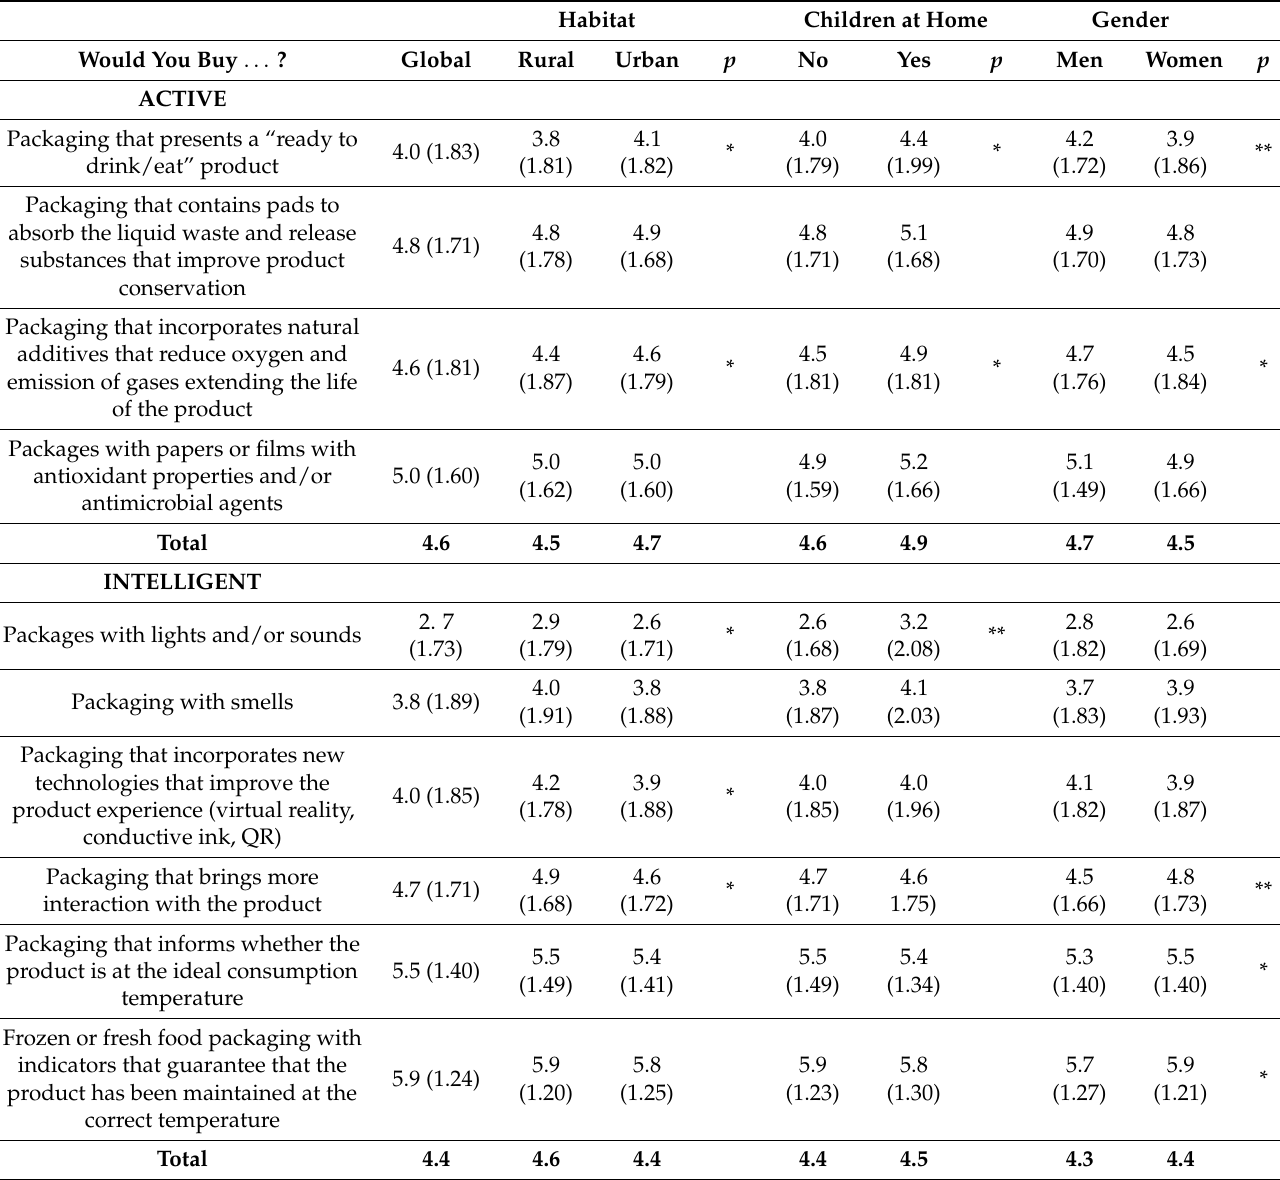
Table 3. Mean values (and standard deviations) of the respondents’ views on purchase intention of AIP. Habitat Children at Home